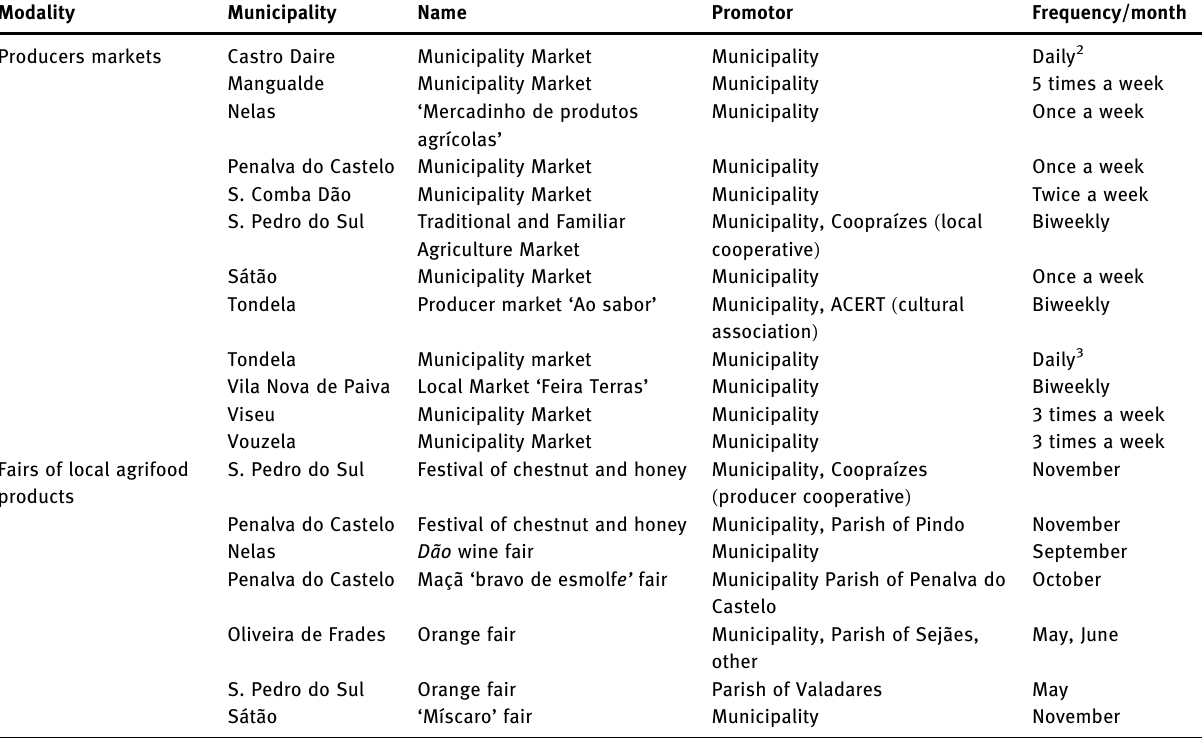
Table 1: Producers markets and fairs of agrifood products in the Viseu Dão Lafões Region